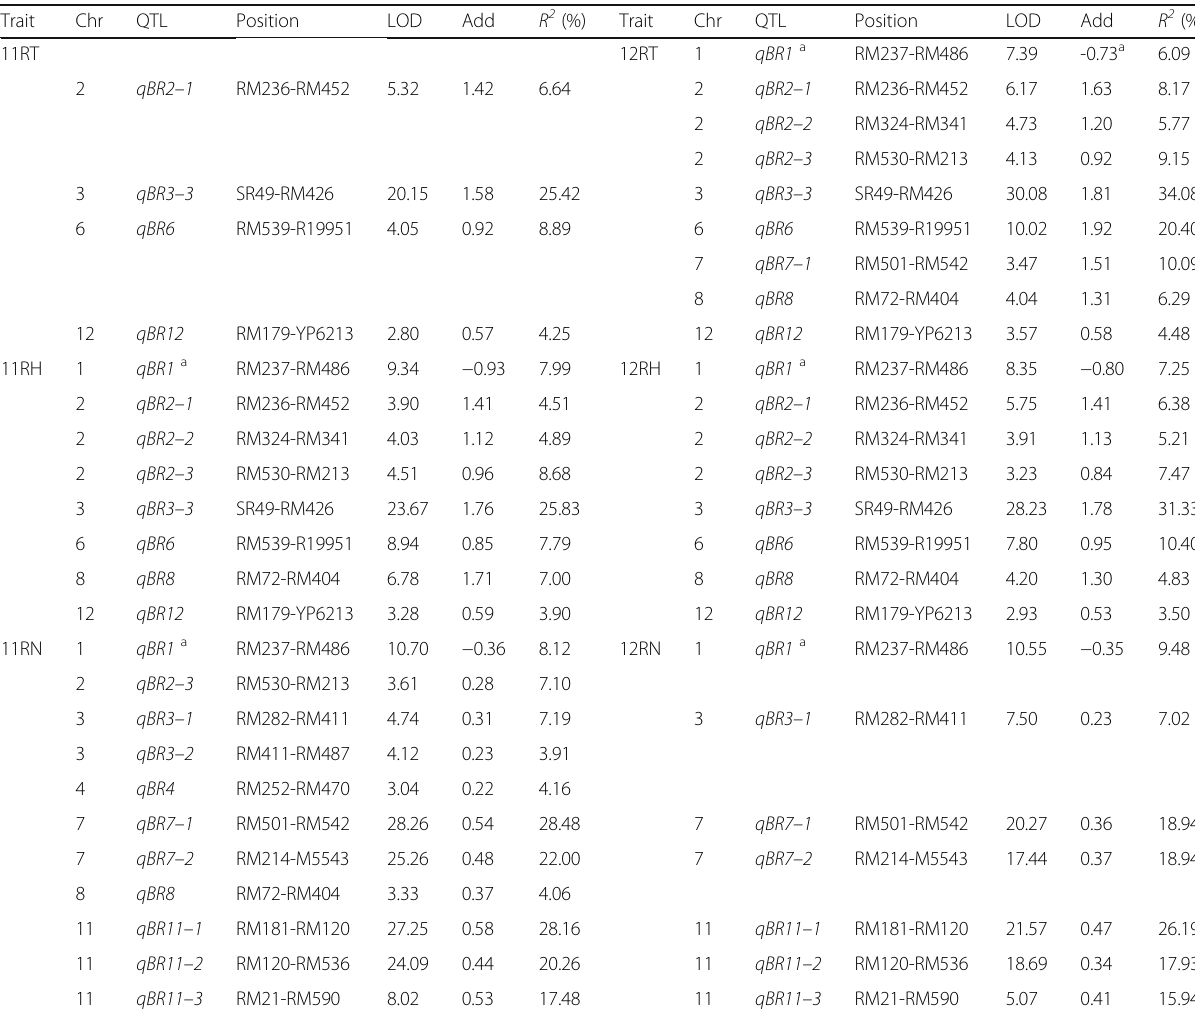
Table 2 QTL mapping results from Jin23B/CR071 background population in 2 years Trait